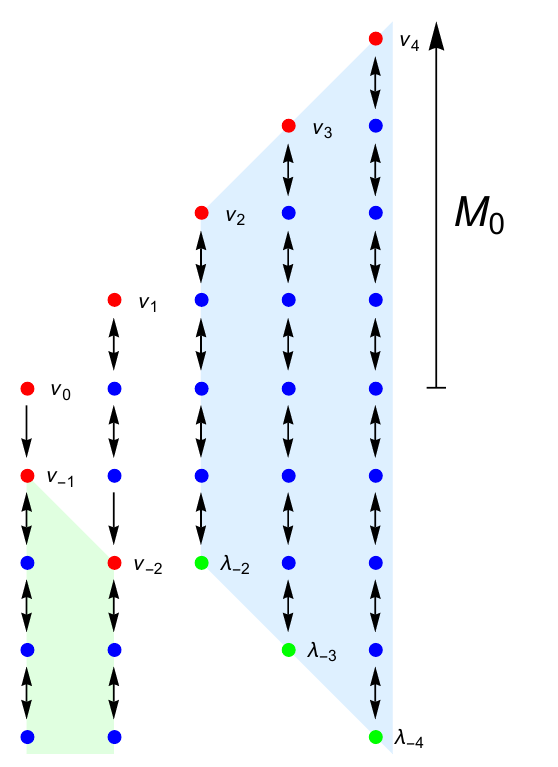
Figure 1 . Weight diagram showing the highest (in red) and lowest (in green) weight states under the Lorentz algebra and their descendants (in blue), for the spin 2 case with (cid:22) h (cid:0) h = 2. An arrow pointing up (down) means that the states are linked by the action of M (cid:0) 1 ( M 1 ). We note that the states (cid:23) (cid:0) 1 and (cid:23) (cid:0) 2 are null primaries. The states in the blue shaded region are the V ( t ) a which form an irreducible representation of the full AdS algebra sl (2 ; R ) (cid:8) sl (2 ; R ). Only the states in the green shaded region are actually